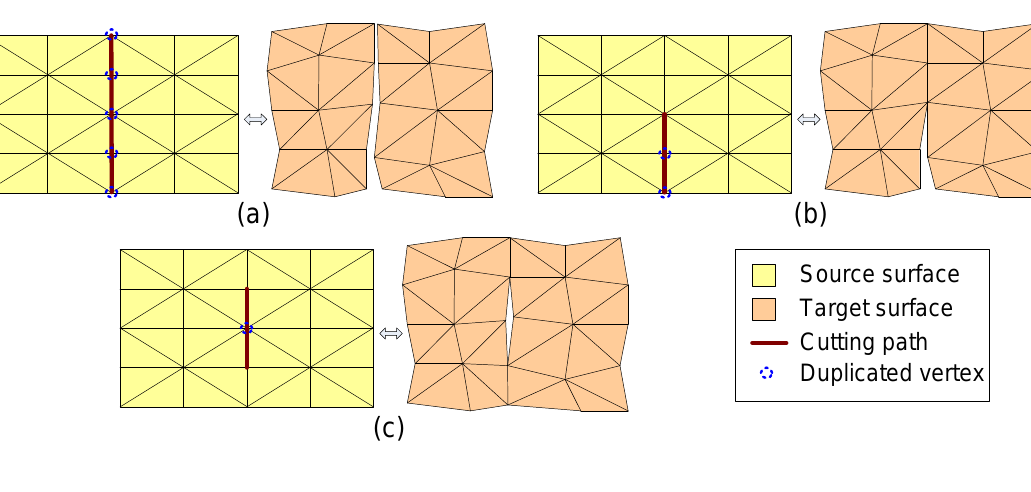
Figure 2. Cutting meshes by cutting paths. ( a ) All vertices and edges are duplicated. ( b ) All vertices and edges, except for a one-end vertex, are duplicated. ( c ) All vertices and edges, except for two-end vertices, are